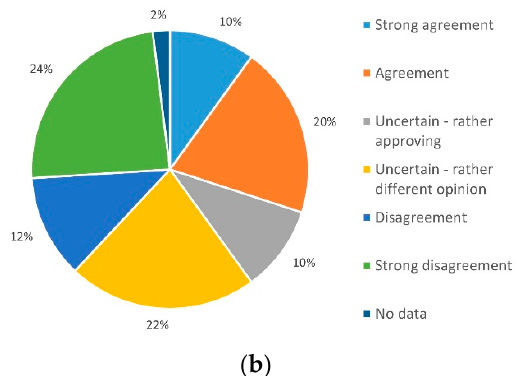
Figure 6. Concerns about ( a ) quality of care and ( b ) responsible staff.